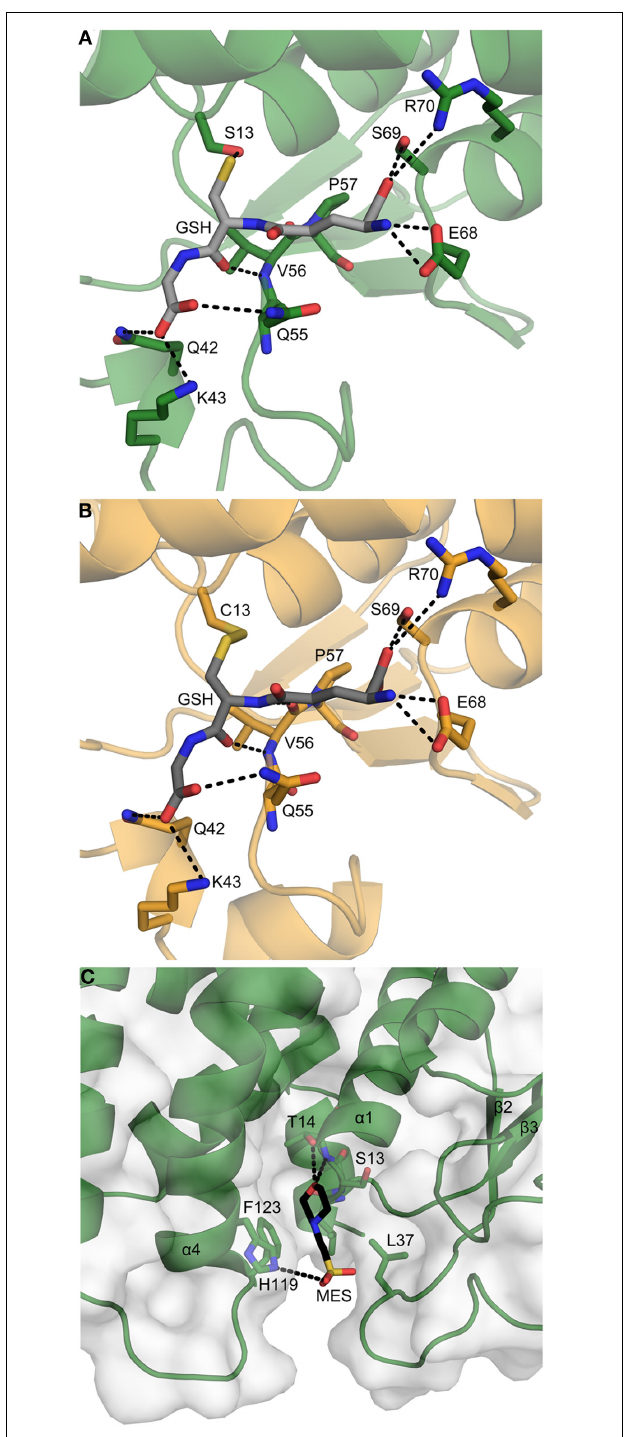
FIGURE 6 | Close up view of the G- and H-sites. (A,B) Glutathione binding site of PttGSTF1 and PttGSTF1 S13C. (C) Electrophilic substrate binding site of PttGSTF1. The PttGSTF1 (dark green) and PttGSTF1 S13C (orange) monomers are shown in cartoon with a transparent molecular surface in (C) . Residues involved in the binding of GSH (gray) and MES (black) molecules are shown as sticks, labeled and colored according to atom type. Putative hydrophilic interactions between the substrates and the enzyme are shown as black dashed